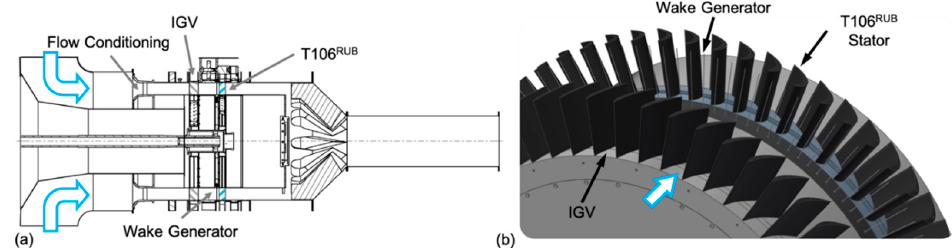
Figure 25. Test facility Axial Turbine II: sectional view ( a ), 3D illustration ( b